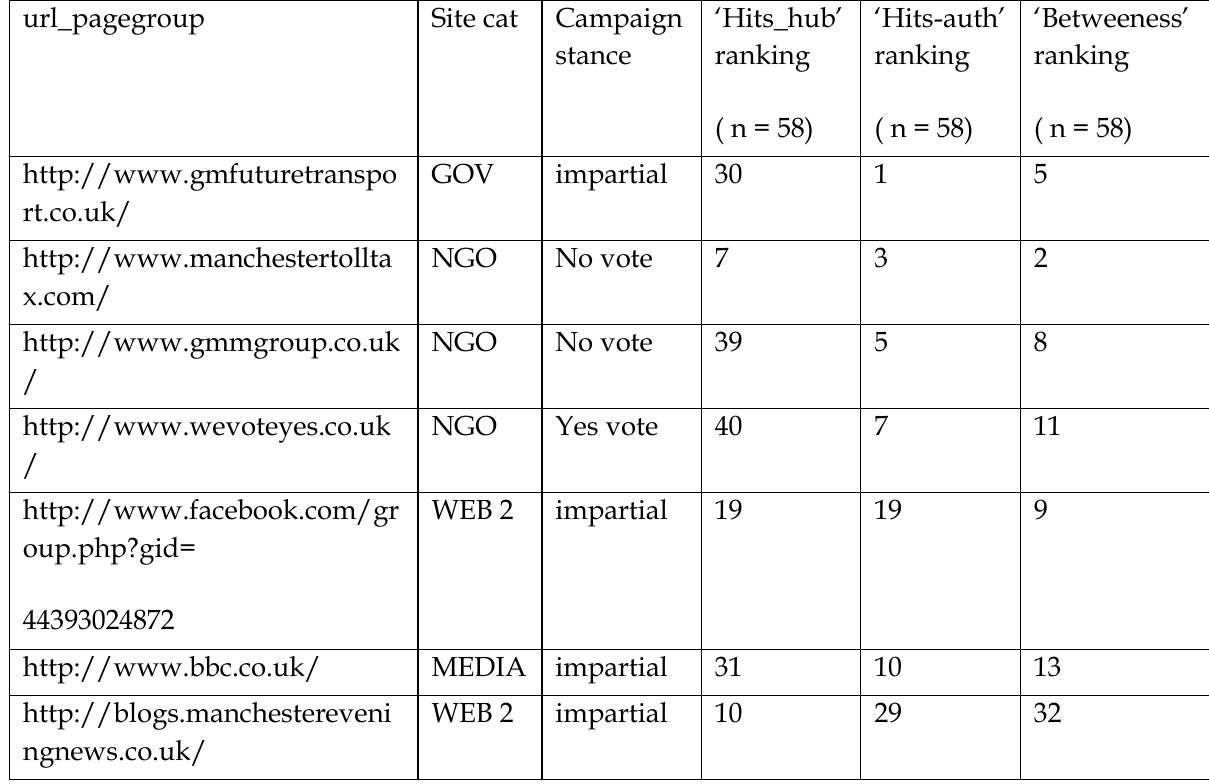
Table 1: Sites selected as prominent in the online